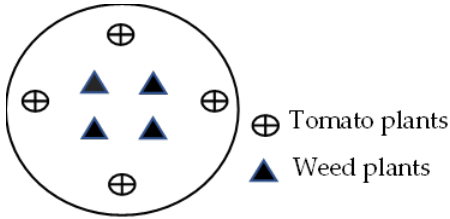
Figure 1. Representation of the experimental setup to evaluate weed-suppressive ability of tomato genotypes against Palmer amaranth, large crabgrass, and yellow nutsedge. Four tomato plants were sown at the edges of the pot, and four plants of a particular weed species were sown in the center of the pot. Table 1. Codes and names of 17 tomato cultivars tested for suppressive ability on Palmer amaranth, yellow nutsedge, and large crabgrass.